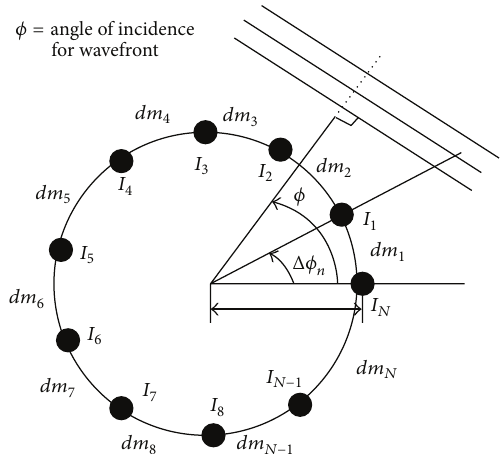
Figure 1: Nonuniform planar circular array geometry in the 𝑥 - 𝑦 axis.